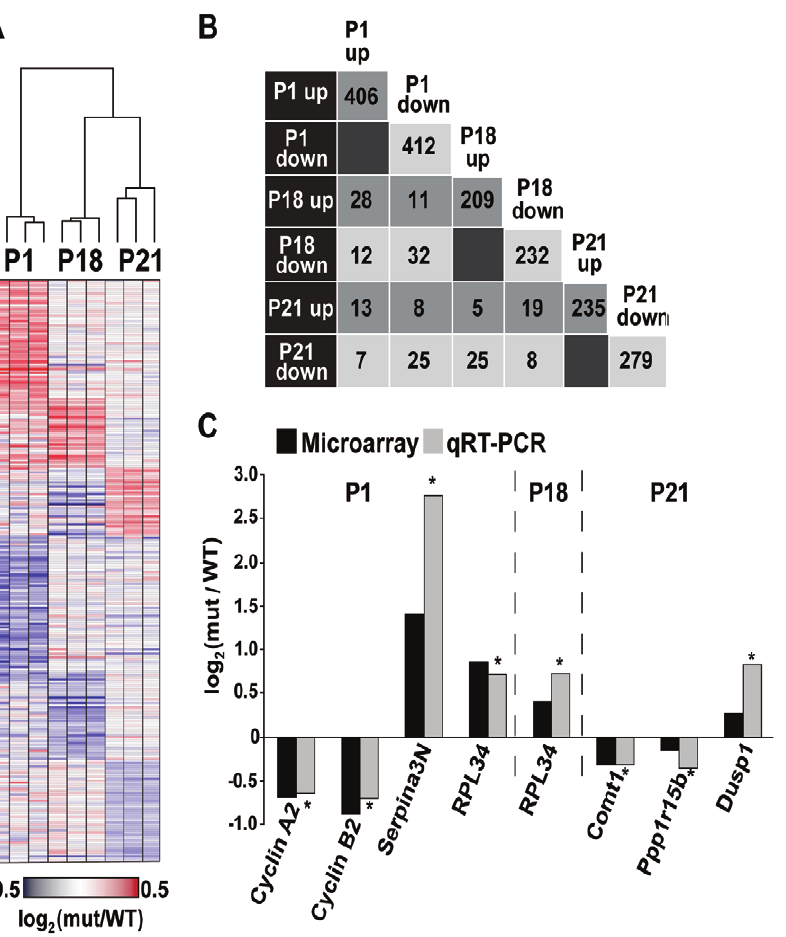
Figure 1. Differential gene expression at three postnatal time points. RNA extracted from the entire brain (cerebellum excluded) of wild- type and mutated mice at P1, P18 or P21 was analyzed for whole genome mRNA expression level by Affymetrix microarrays. File S1 lists all the differentially expressed genes. (A) Heatmap of relative gene expression in mutant mice when compared to wild type. For each mutant mouse, the expression level relative to the average of the three WT mice is shown. For visualization purposes, only genes exhibiting fold-change . 1.35 (p , 0.05) are shown. Red indicates higher expression in the mutant and blue indicates higher expression in the wild type. The dendogram shows a hierarchical clustering of the expression levels of all the genes using average linkage. (B) The number of genes that are differentially expressed at two different time points (fold-change . 1.2; p , 0.05). ‘up’ and ‘down’ refer to elevated or lower expression level, respectively, in the mutant relative to the wild- type mice at each time point. (C) Validation of selected differentially expressed genes. For validation, RNA was extracted from additional brains of wild-type and mutant mice at each developmental time point. Ratio of mRNA levels [log 2 (mutant/wild-type)] of the specific indicated genes determined by Affymetrix microarrays is shown (black) alongside with its level as detected by qRT-PCR and calculated relative to GAPDH control (gray). The qRT-PCR data represents the average of 3 biological samples (p , 0.05).